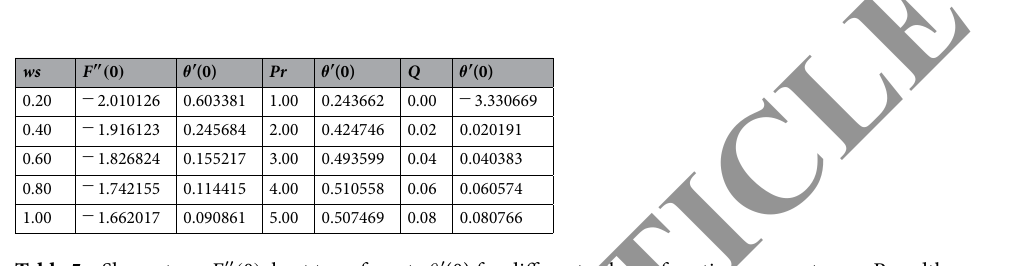
Table 5. Shear stress F ′′ ( 0 ) , heat transfer rate θ ′ (0) for different values of suction parameter ws , Prandtl number Pr and heat generation/absoprtion Q .